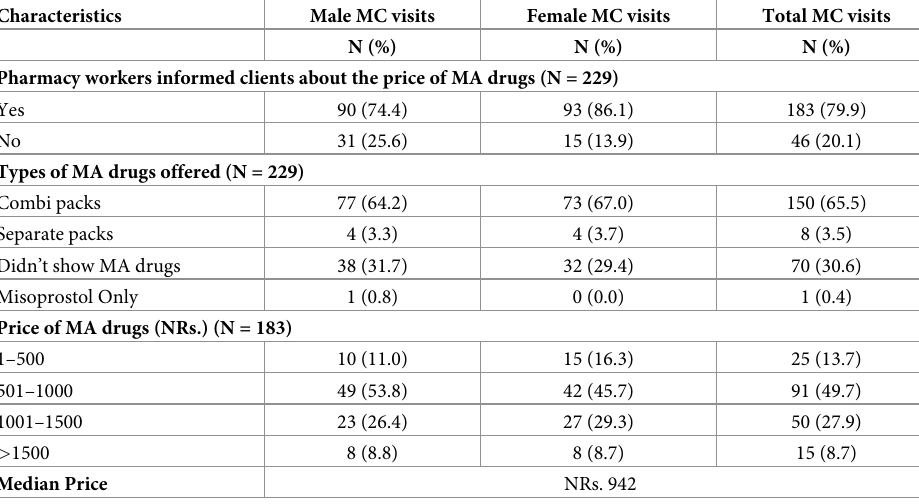
Table 6. Type and price of MA drugs. Characteristics Male MC visits Female MC visits Total MC visits N (%) N (%) N